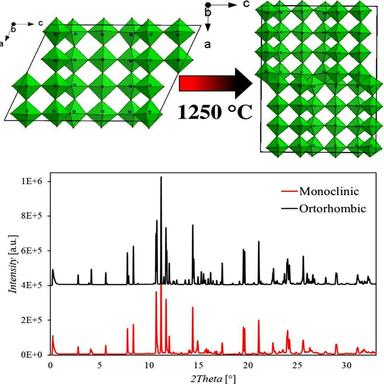
Unit cell of both monoclinic and ortorhombic FeNb11O29 and corresponding synchrotron powder diffraction patterns.